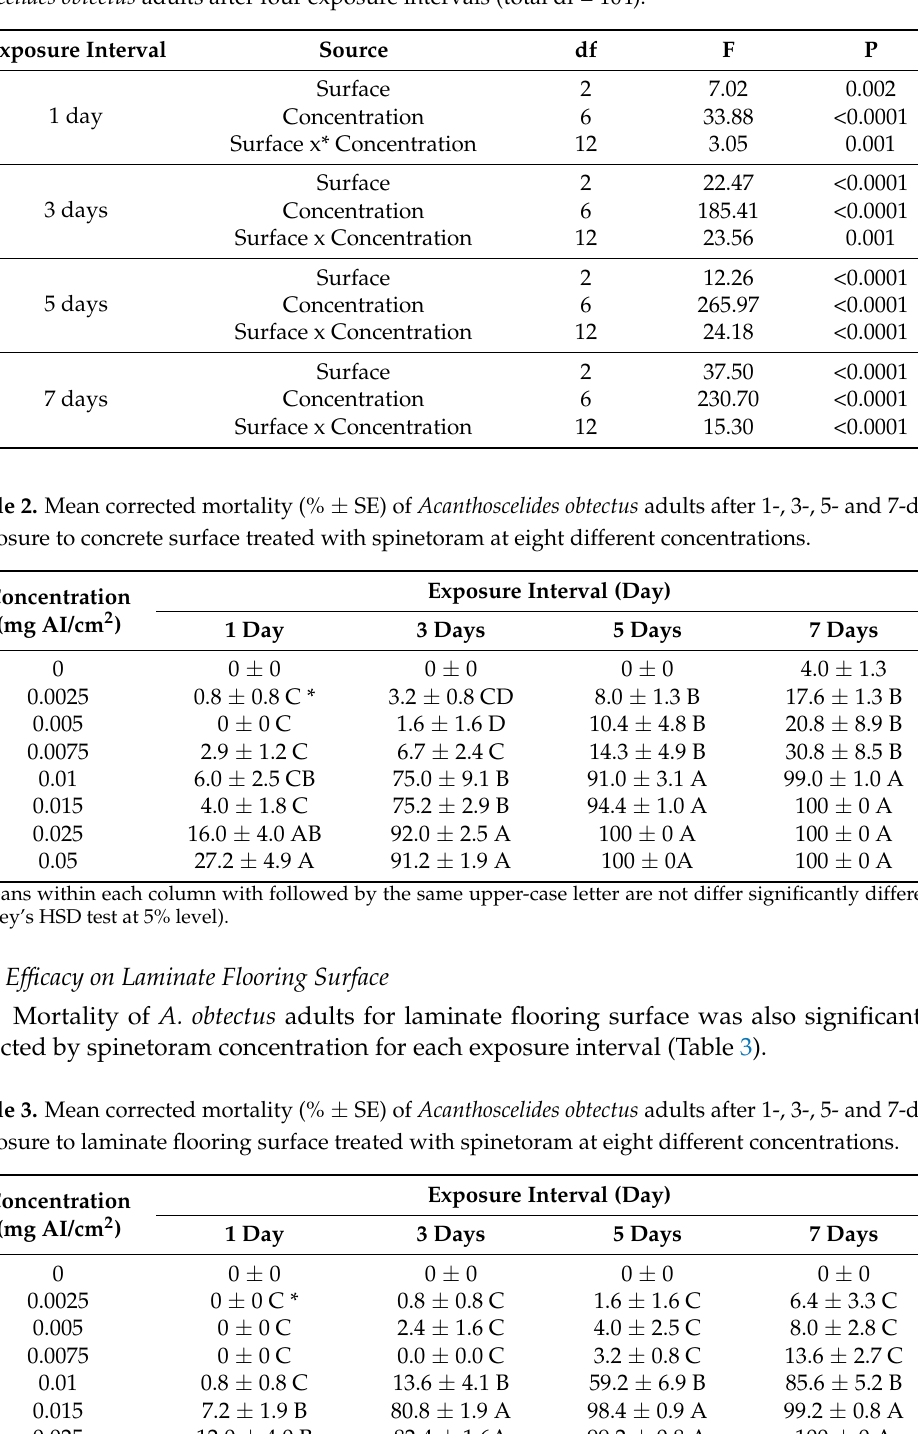
Table 1. ANOVA parameters for main effects and associated interactions for mortality of Acan- thoscelides obtectus adults after four exposure intervals (total df = 104).